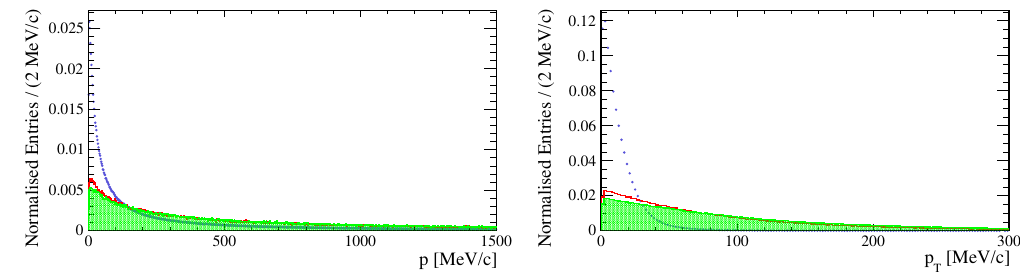
Figure 8 . Momentum (left) and transverse momentum (right) for electrons generated in various strangeness decays, where the dotted blue represents (cid:3) and (cid:12)lled green K 0 (cid:22) + (cid:22) (cid:0) e + e (cid:0) S !